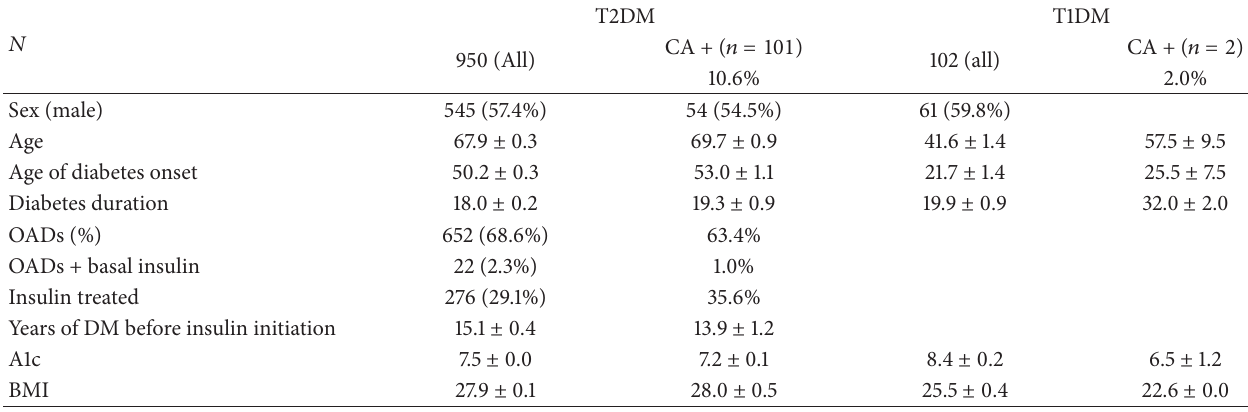
Table 3: Data of all patients with at least 10-year diabetes duration examined for the first time during the last 25 years but lost to follow-up after at least one-year regular visits.